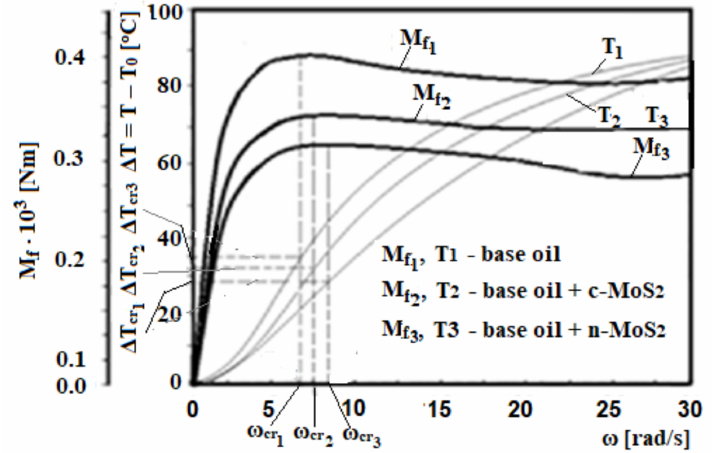
Figure 4. Variations of M f and T depending on ω (results obtained experimentally for base oil, base oil + c-MoS 2 , and base oil + n-MoS 2